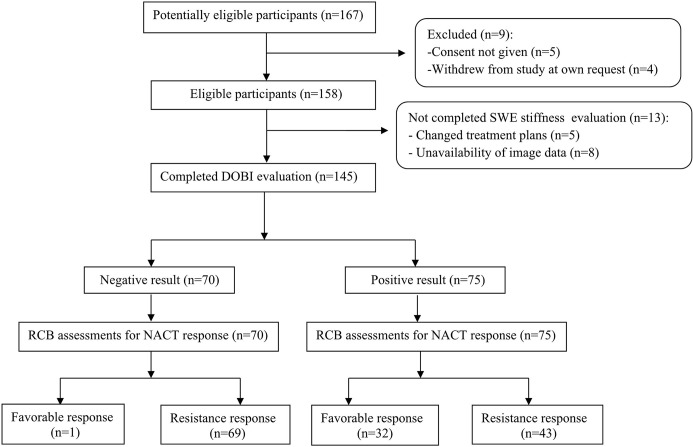
STARD flow chart of patient inclusion. BS2 in ‘DOBI evaluation’ for the prediction of favorable responses is used as an example.